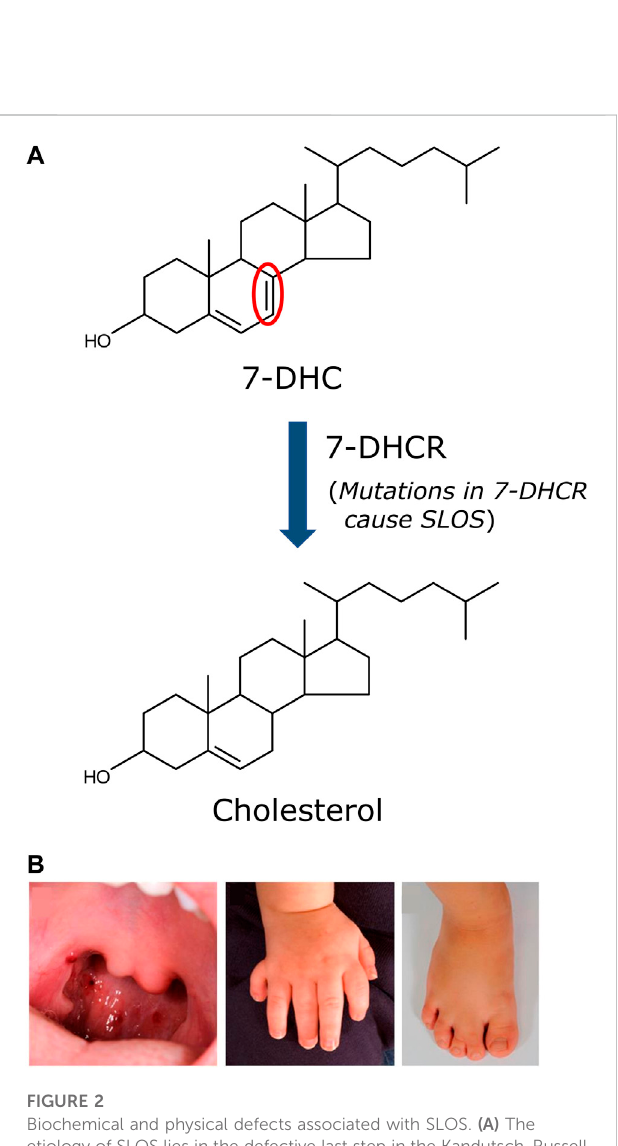
FIGURE 2 Biochemical and physical defects associated with SLOS. (A) The etiology of SLOS lies in the defective last step in the Kandutsch-Russell pathway of cholesterol biosynthesis, i.e., the conversion of 7-DHC to cholesterol. The enzyme catalyzing this step (7-DHCR) loses its ability to ef fi ciently convert 7-DHC to cholesterol due to mutations in 7- DHCR detected in SLOS patients. More than 150 mutations in 7-DHCR have been reported in SLOS patients. This results in accumulation of 7- DHC and an altered cholesterol/total sterol ratio, a clinical parameter used to detect and diagnose SLOS. The severity of SLOS depends on the degree of functional impairment of the enzyme. The only difference between cholesterol and 7-DHC is the mere presence of an additional double bond (highlighted in red). (B) Representative anatomical defects displayed by SLOS patients. The anatomical defects associated with SLOS include cleft palate, polydactyly and syndactyly. Adapted and modi fi ed from (Porter and Herman 2011).